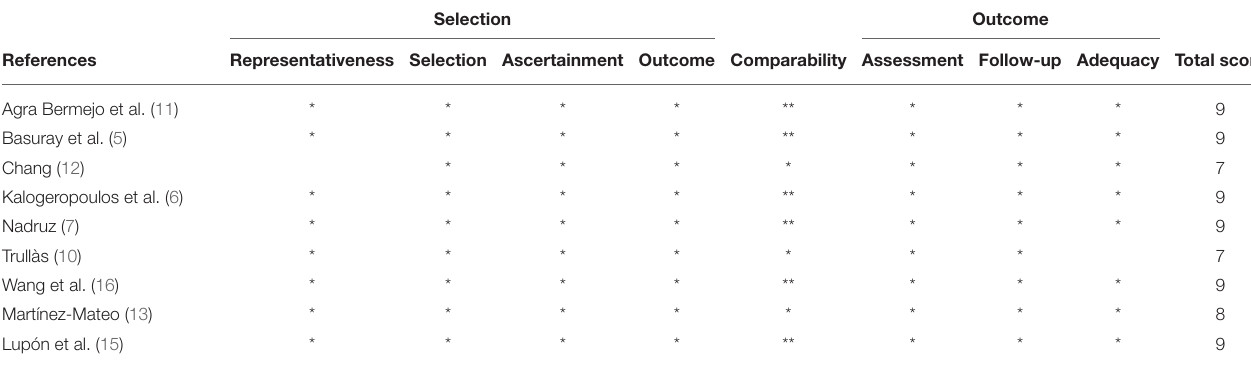
TABLE 2 | Newcastle–Ottawa scale scores and quality assessment of included studies. Selection